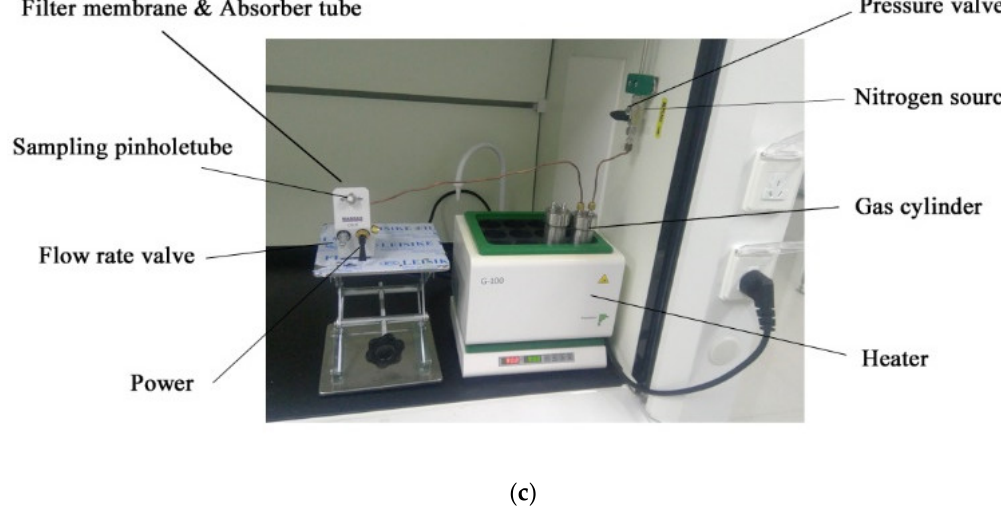
Figure 1. ( a ) Diagram of microwave workstation for baking treatment of adzuki beans. ( b ) Roasting drum device for baking treatment of adzuki beans. ( c ) Purge and trap device for detection of volatile compounds in baked beans.